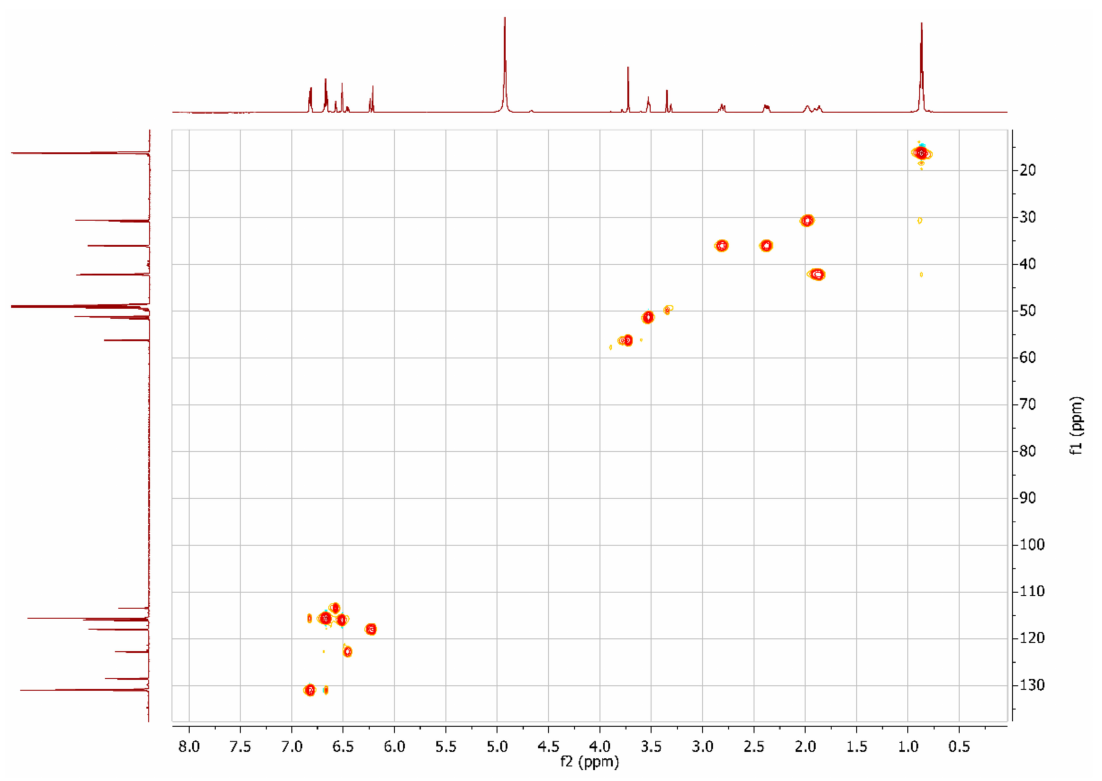
Figure A5. 1H-13C (HSQC) NMR (CD3OD, 600 MHz) of 30 3 (cid:48) -demethoxy-6-O-demethylisoguaiacin ( 1 ) and norisoguaiacin ( 2 ) 31.